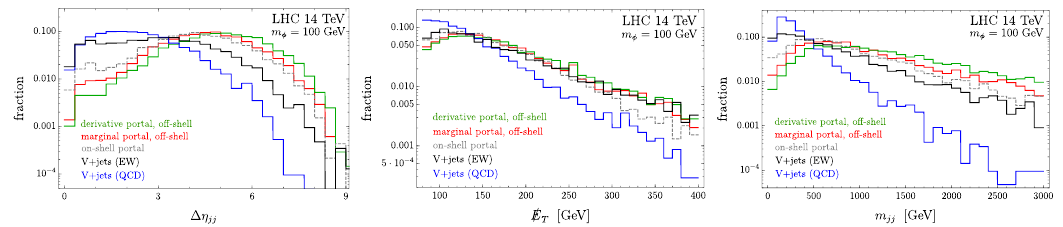
Figure 6: Normalized distributions at the 14 TeV LHC for the signals with m φ = 100 GeV and the main backgrounds, after the baseline cuts. For reference we also show normalized distributions for the on-shell signal. Table 5: Cross sections in fb. The baseline cuts are given in Eq. (18). For 3 ab − 1 we have S = 0.15 [ 0.38 ] for the derivative [ marginal ] portal. A dash indicates that our MC statistics is insufficient to estimate the cross section. No EFT consistency condition is